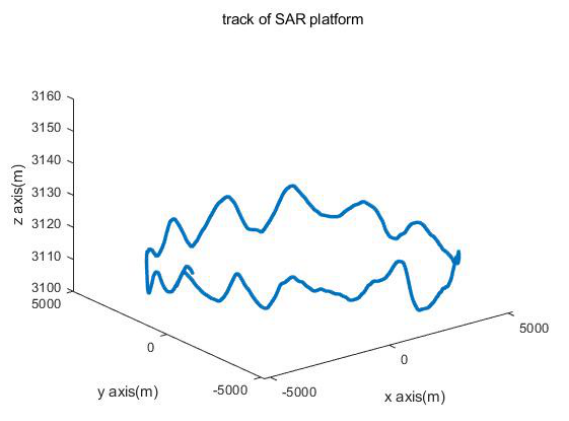
Figure 9. Track of synthetic aperture radar(SAR) platform.